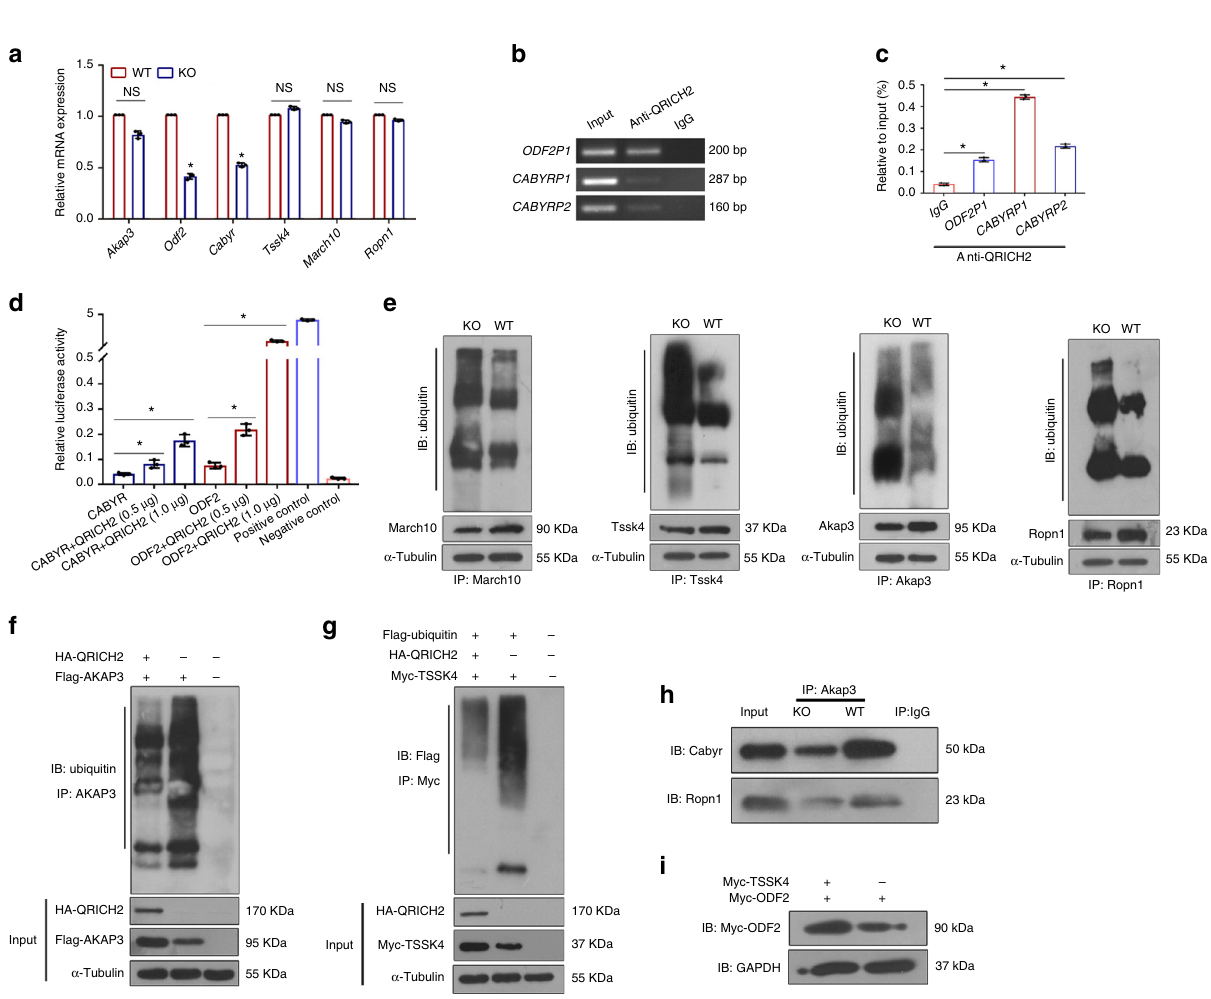
Fig. 6 The mechanisms of QRICH2 regulating sperm fl agellar formation. a The mRNA levels of Akap3 , Odf2 , Tssk4 , March10 , Cabyr and Ropn1 in the testes of the KO and WT mice. The reduced mRNA levels of Odf2 and Cabyr in the KO mice were detected by real-time PCR (Student ’ s t -test; n = 3 independent experiments; * p < 0.05; NS, not signi fi cant; error bars, s.e.m). b One QRICH2-occupied site in the ODF2 promoter and two QRICH2-occupied sites in the CABYR promoter were detected by ChIP-PCR assays of human testicular tissues. Input DNA and normal mouse IgG pulldowns were used as positive control and negative control, respectively. c ChIP-qPCR results showed the increased binding of QRICH2 to the ODF2 and CABYR promoter regions in the group with QRICH2 antibody compared to that with IgG (Student ’ s t -test; n = 3 independent experiments; * p < 0.05; error bars, s.e.m). d QRICH2 could enhance the transcriptional activity of ODF2 and CABYR by luciferase reporter assays (Student ’ s t -test; n = 3 independent experiments; * p < 0.05; error bars, s.e.m). e The increased ubiquitination levels of Akap3, Tssk4, Ropn1 and March10 in the testes of the KO mice compared with that in the WT mice. f , g QRICH2 decreased the ubiquitylation of exogenous AKAP3 ( f ) and TSSK4 ( g ) in HEK 293 cells. The cells were harvested after a 6-h treatment with 10 μ M of MG132. h The binding of Ropn1 and Cabyr to Akap3 was weakened in the testes of the KO mice compared with that in the WT